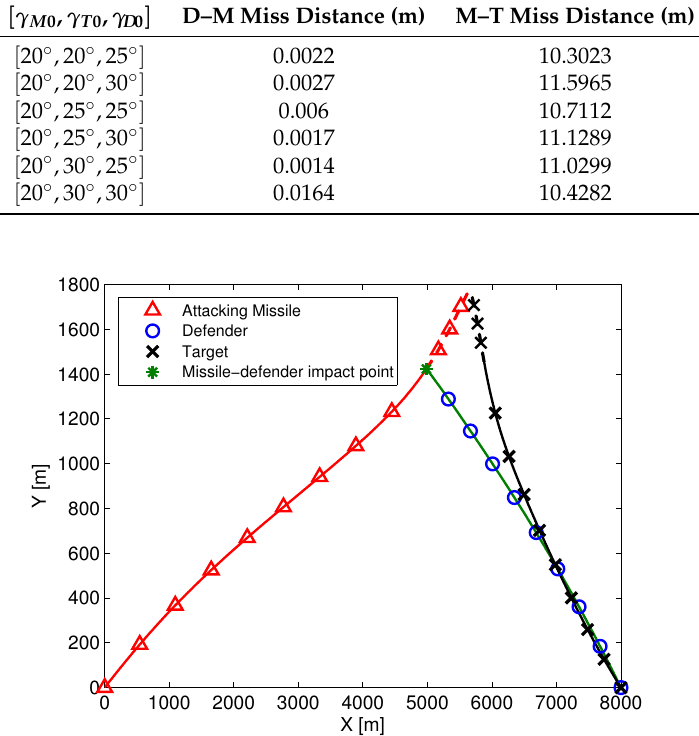
Figure 4. The trajectories of three aircraft in the case of [ γ M 0 , γ T 0 , γ D 0 ] = [ 20 ◦ ,25 ◦ ,30 ◦ ] .